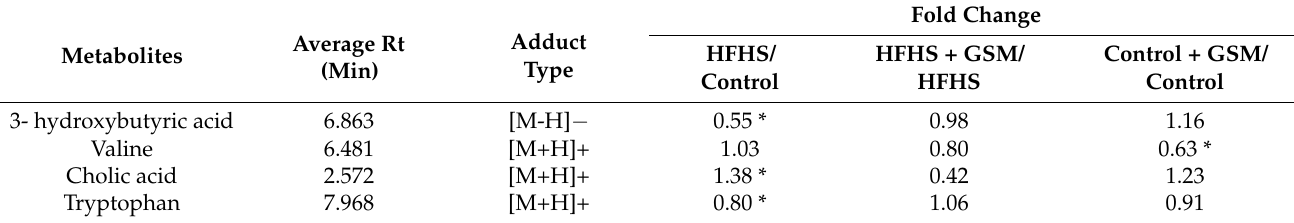
Table 4. Plasma metabolite biomarkers affected by HFHS diet or GSM treatment in sham